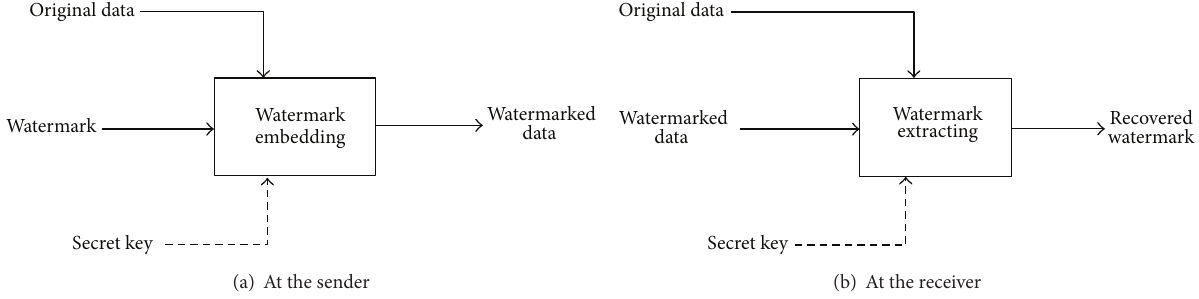
Figure 1: Classical nonblind watermarking